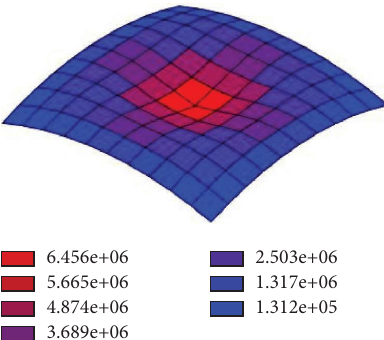
Figure 13: Von mises stress contours of the shallow spherical